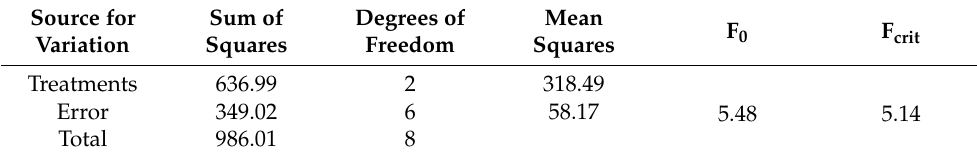
Table 7. The ANOVA results for the maximum stress. Source for Sum of Variation